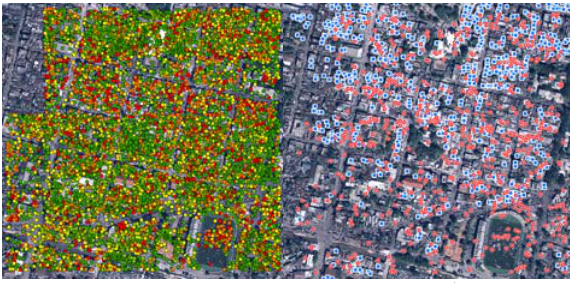
Figure 7 Left: Prediction of collapsed buildings (green = 0-0.4, yellow = 0.4-0.6, orange = 0.6-0.8, red = 0.8-1.0). Right: Image overlaid with reference data (blue) and classified segments (red).